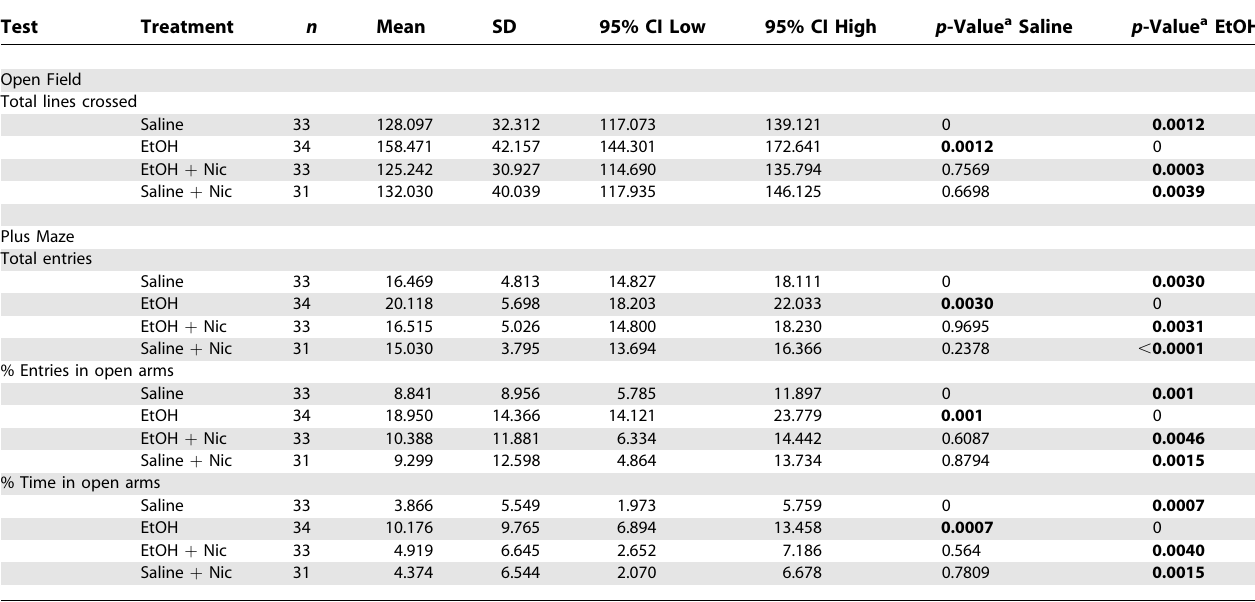
Table 1. Nicotinamide Reverts Ethanol-Induced Hyperactivity in Adult Mice